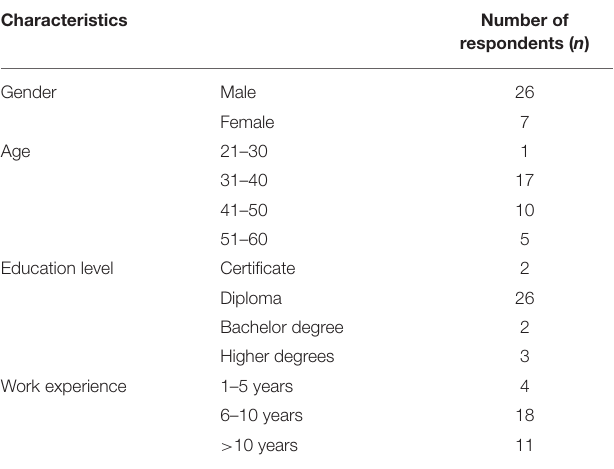
TABLE 2 | Demographic characteristics of the survey